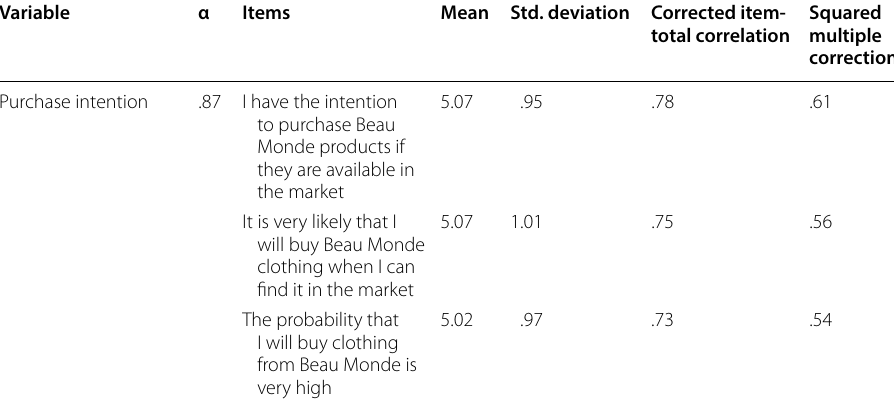
Table 3 Stepwise regression results for evaluation intention